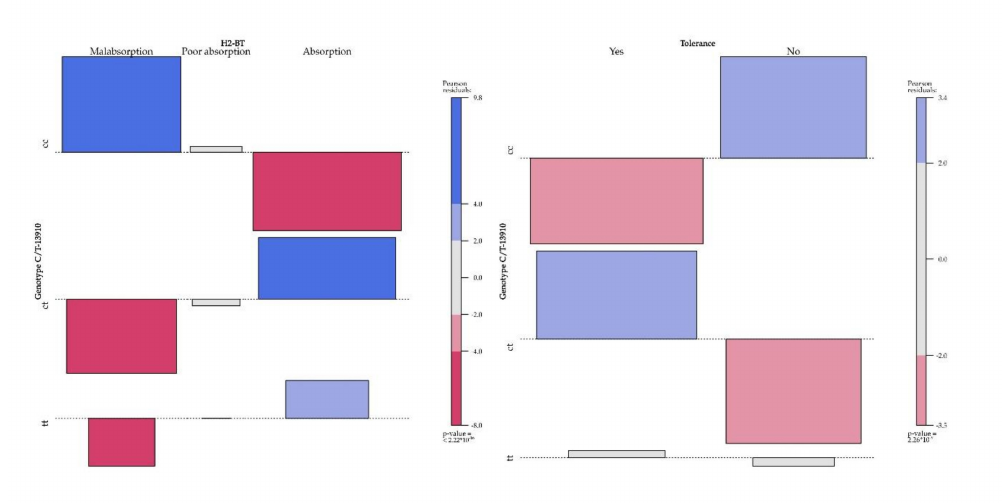
Figure 1. Lactose absorption and tolerance according to C / T-13910 genotype. For the CC genotype, the frequencies of lactose malabsorption and lactose intolerance were higher than expected (positive values shown in blue). Conversely, for the CT genotype, the frequencies of lactose absorption and tolerance were higher than